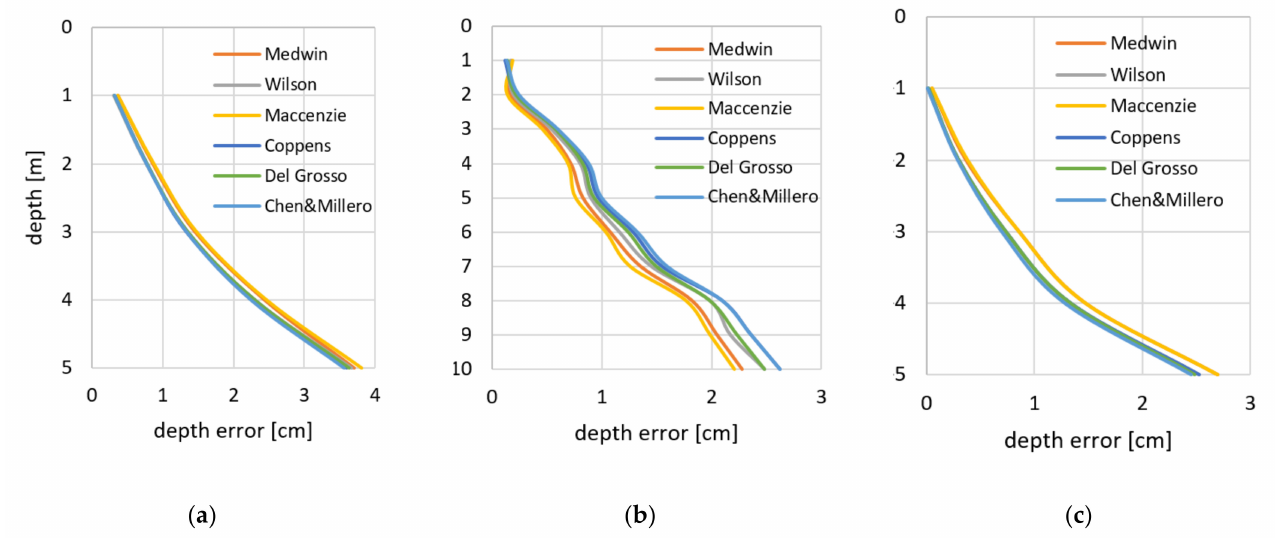
Figure 12. Depth error for measurements in the Motława ( a ) and Martwa Wisła ( b ) Rivers and Gdynia ( c ).